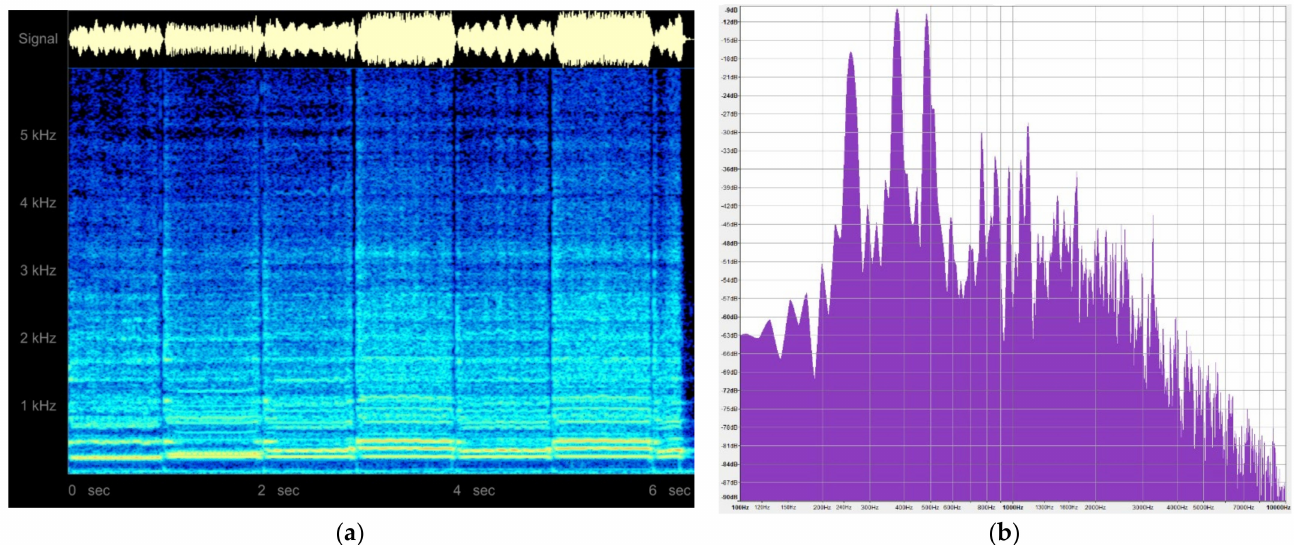
Figure 22. Spectral components of quadruple flute at the Zacuala Palace, Teotihuacan (MNA, Inv. 10-223540), low blowing pressure: ( a ) spectrogram, succession of different finger combinations on pipes A-B-C; ( b ) spectrum, excerpt of position 4 of the larger sample (Sample